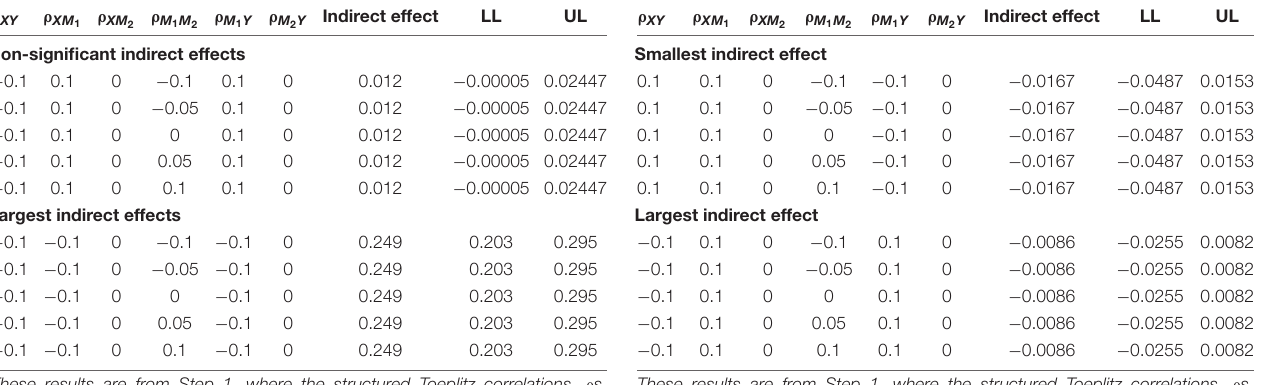
TABLE 2 | A sample of sensitivity results for largest and smallest indirect effect through slope for zero to small confounder correlations. ρ